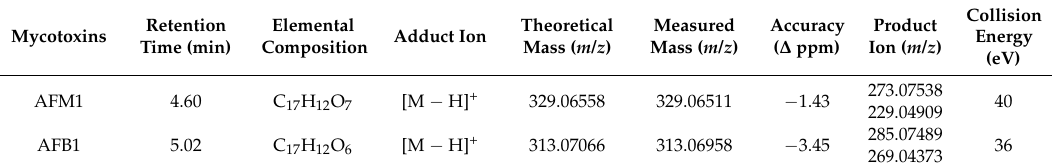
Ultrahigh performance liquid chromatography coupled with high resolution mass spectrometry (UHPLC-HRMS) parameters of the studied